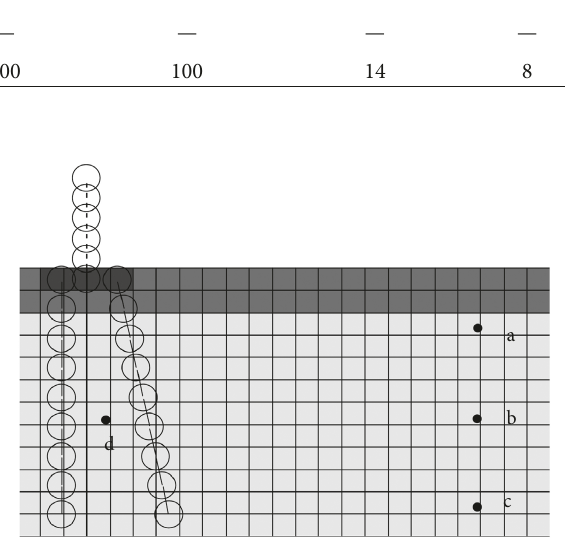
Figure 9: Arrangement of the monitoring location. Table 4: Information of the monitoring